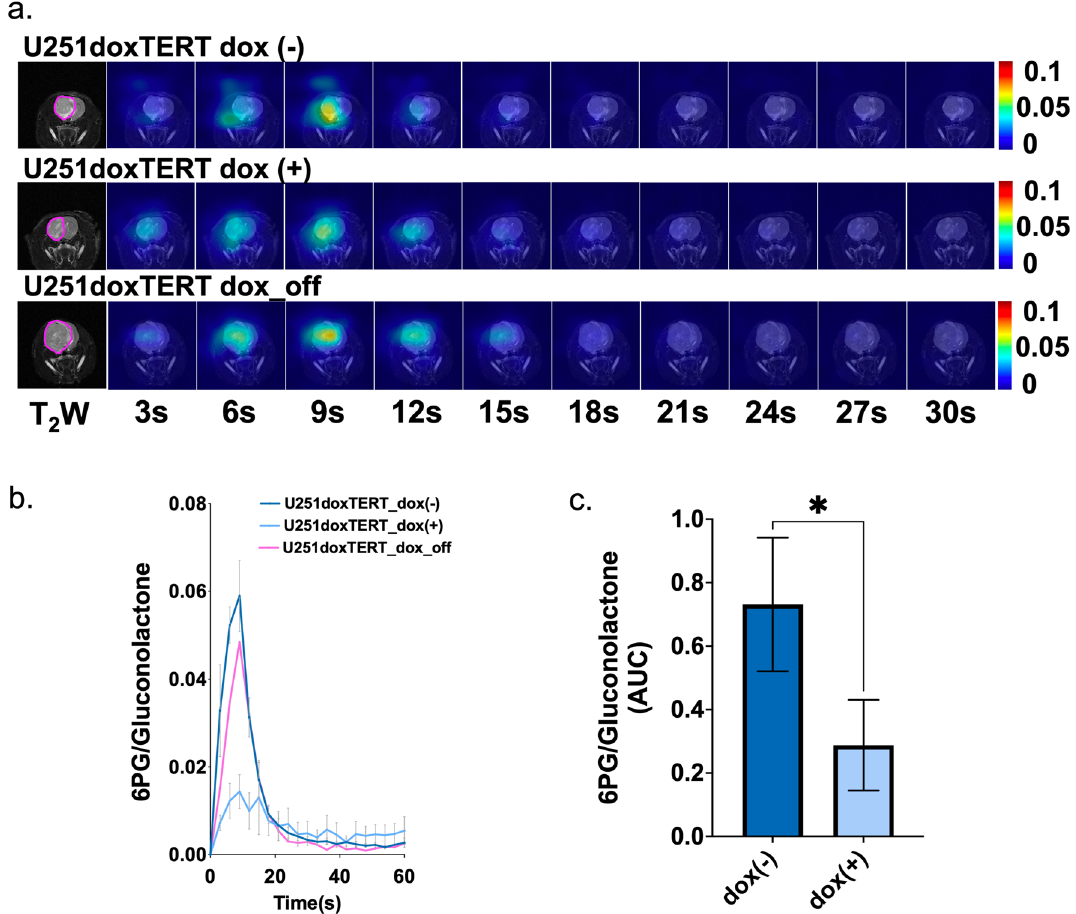
Figure 6. ( a ) Dynamic hyperpolarized 13 C echo-planar spectroscopic imaging data set of [1- 13 C]6PG acquired with 3 s temporal resolution. ( b ) Temporal evolution of [1- 13 C]6PG comparing U251doxshTERT tumors prior to (dox( −)), following (dox( +)) and after removal (dox_off) of doxycycline. ( c ) The AUC of [1- 13